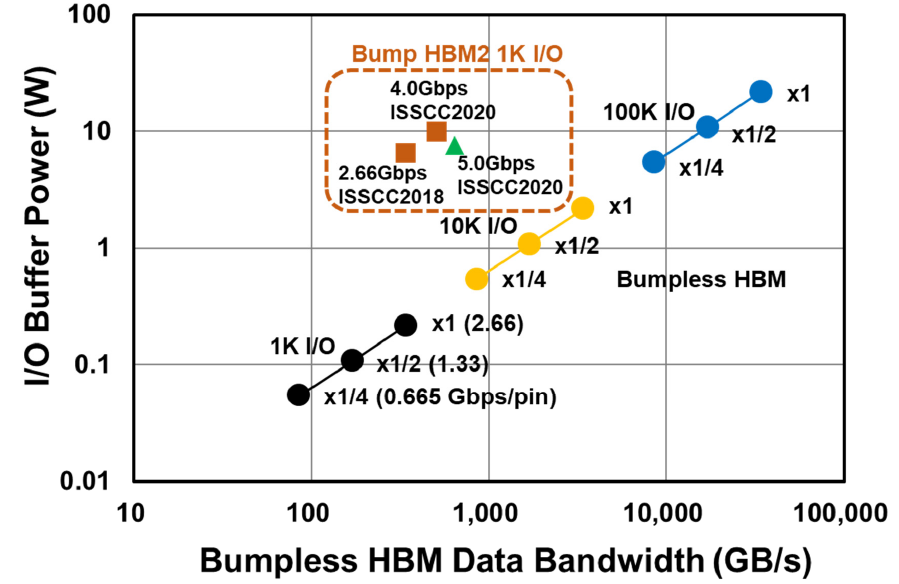
Figure 39. Data bandwidth and I/O buffer power comparison [85–87].